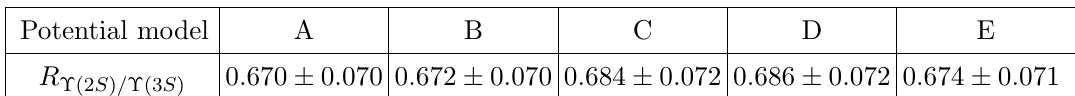
Table 12 . Results for the ratio R potential models of section